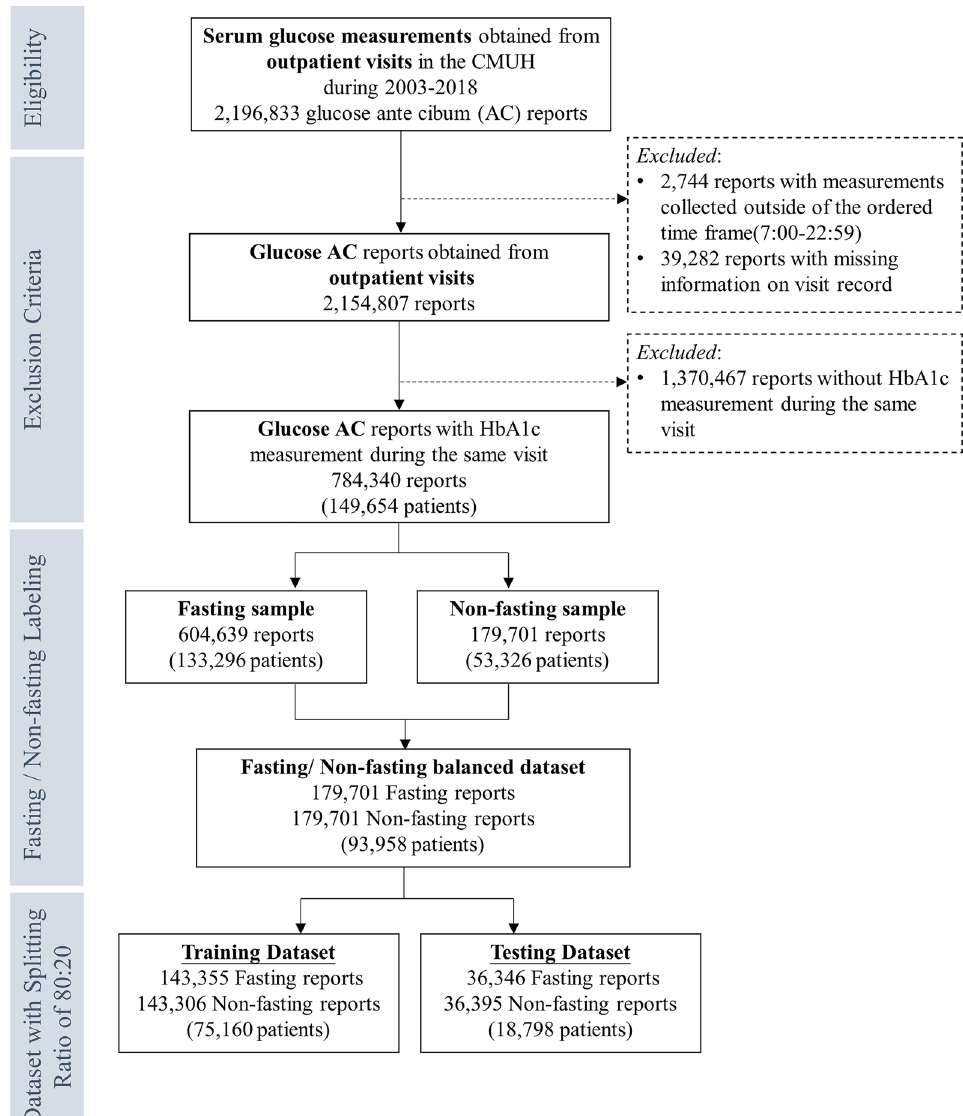
Figure 1. Sample selection process from ontological glucose ante cibum (AC) to theoretical fasting classification, followed by splitting of the dataset into training and testing